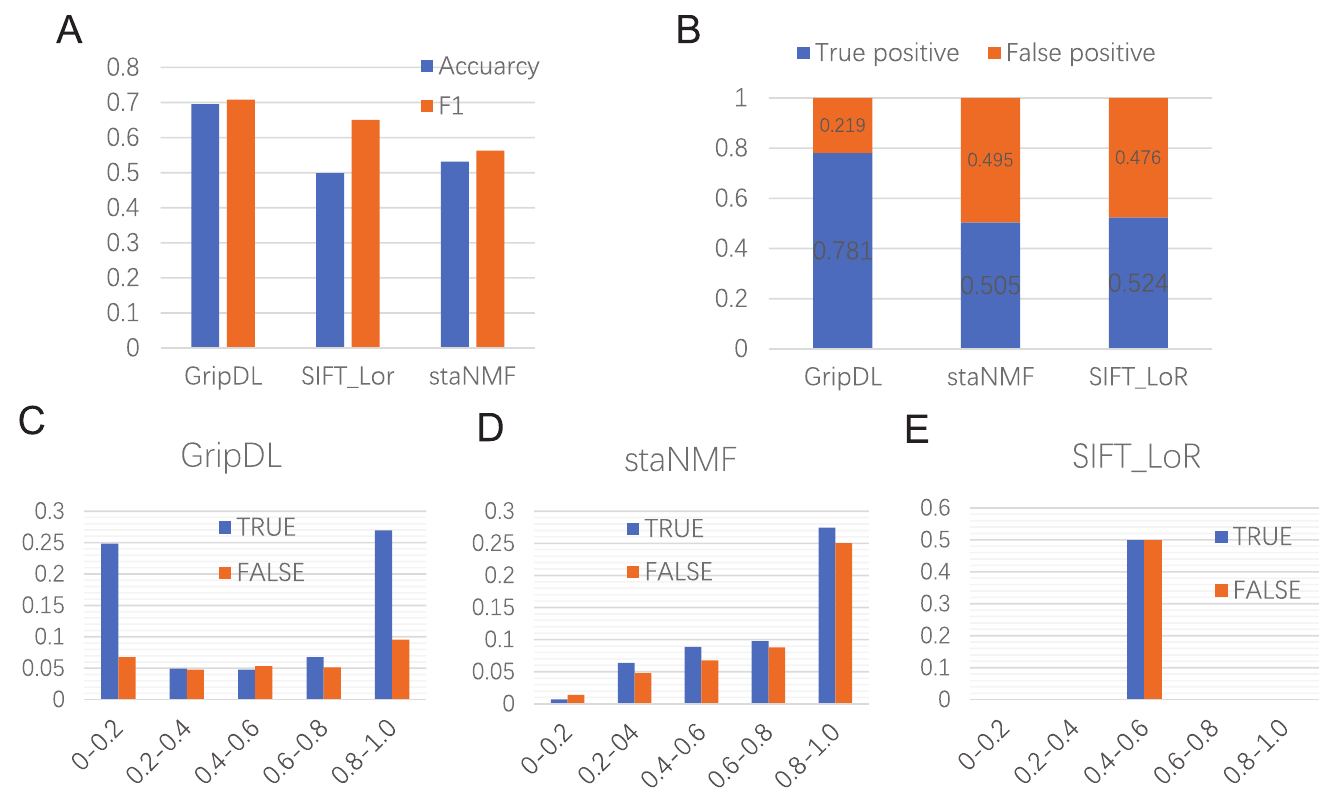
Fig 3. Prediction performance on the benchmark set. (A) shows the overall accuracy and F 1 on the test data in the benchmark set. (B) shows the true and false positives of the top 10% predictions among the test data. (C), (D) and (E) show the distribution of true and false predictions at different output ranges of GripDL, NMF and SIFT_LoR,